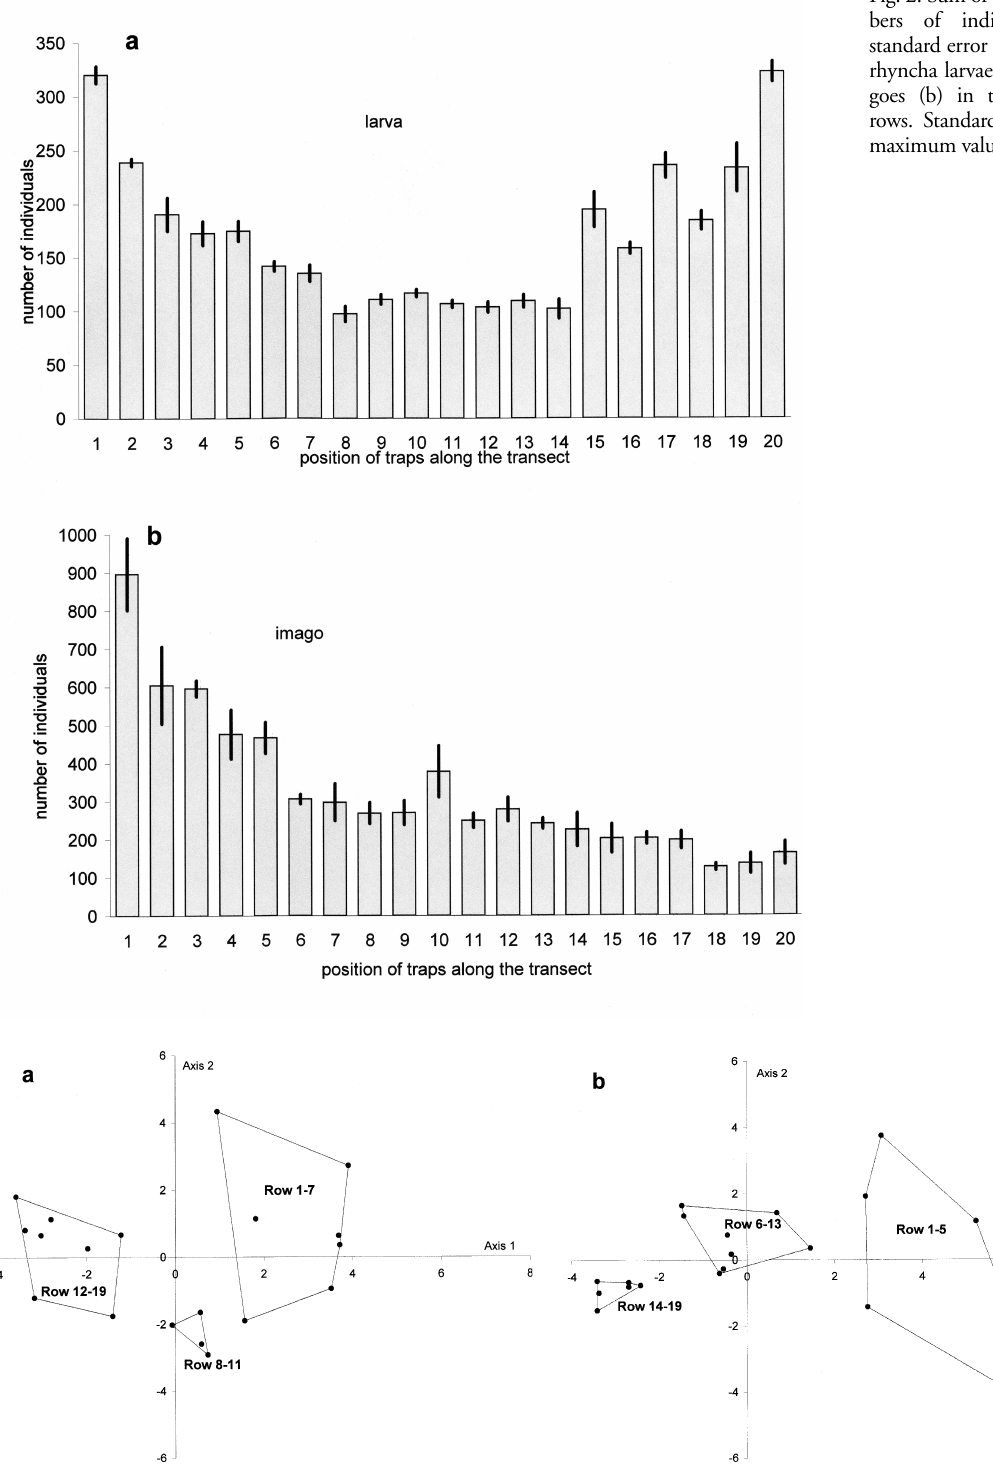
Fig. 3. Principal component analysis (PCA) scattergram of Barber trap rows (sampling sites, as objects) according to the seasonal occurrence of Auchenorrhyncha larvae (a) and imagoes